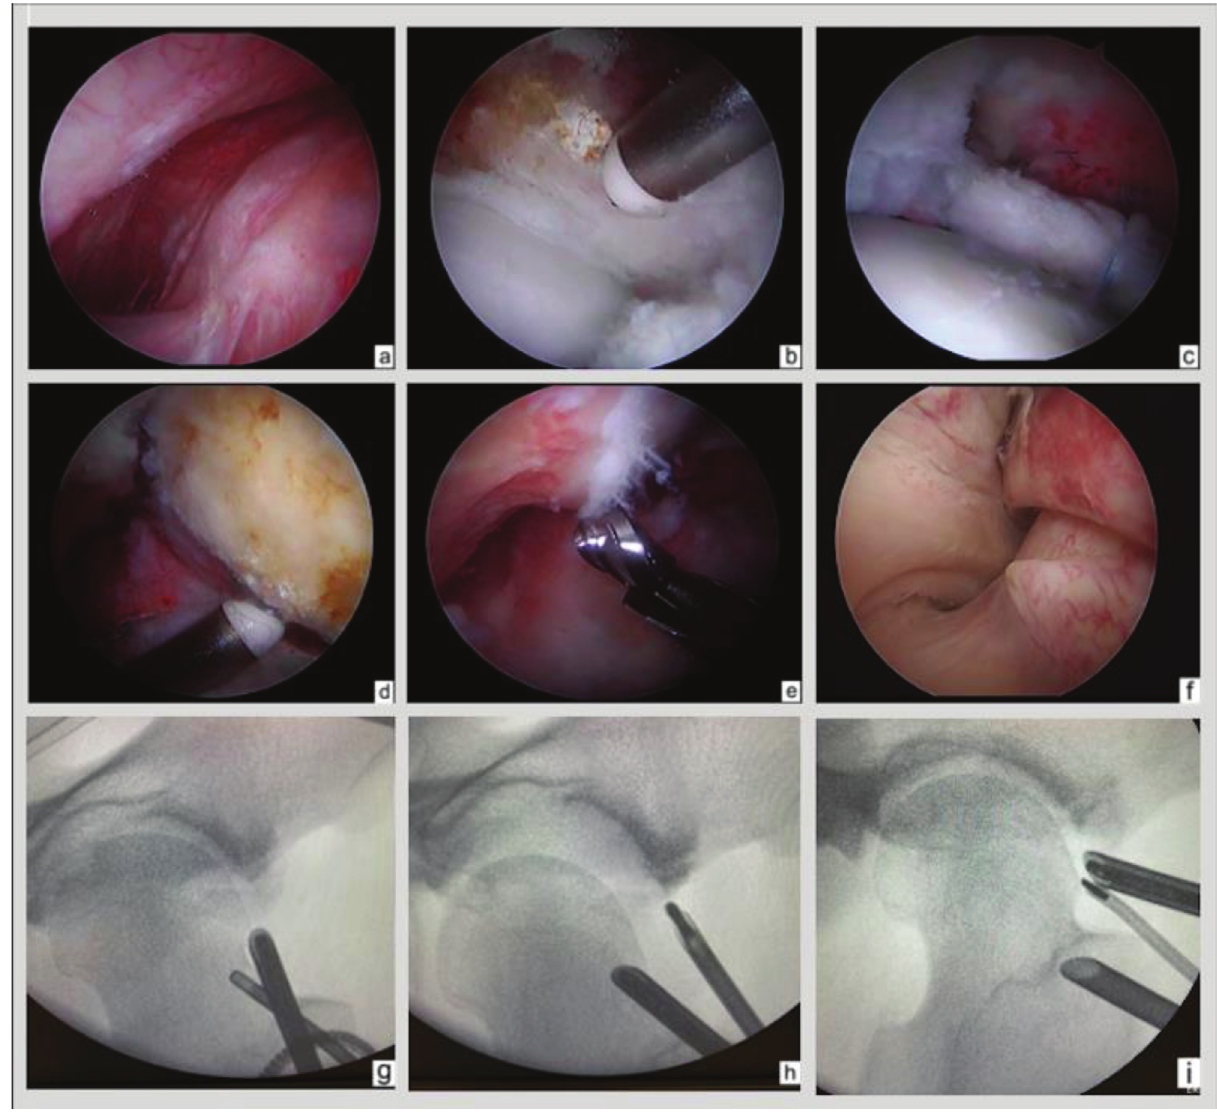
Figure 1. Graded surgical steps. a: Locating the medial plica, b: Acetabular step – exposure of the acetabular clamp, c: Labrum suture and “ suction cup effect ” , d: Femoral step – exposure of the femoral cam, e: Femoral step – control of the femoral resection, f: Locating the vessel, g: Preoperative imaging of the forceps, h: Checking clamp resection, i: Preoperative imaging of the